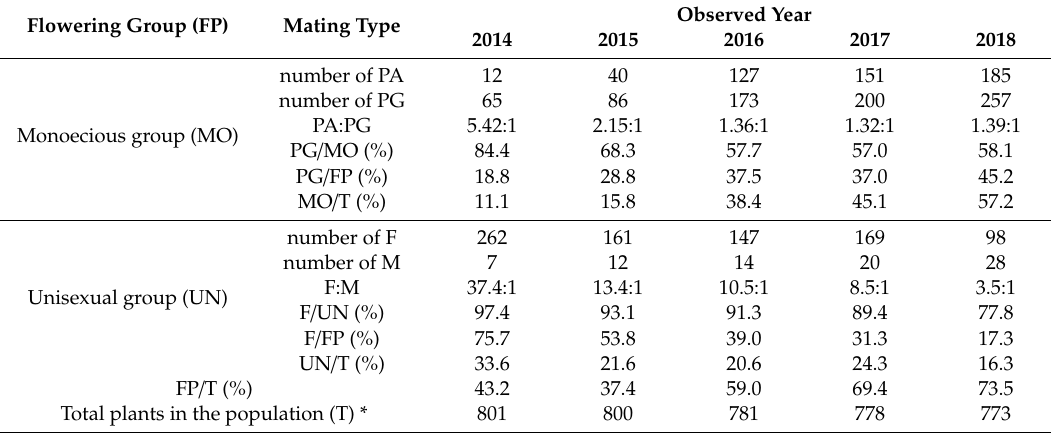
Table 1. Annual expression of various flowering phenotypes in the juvenile plantation of C. paliurus . Flowering Group (FP) Mating